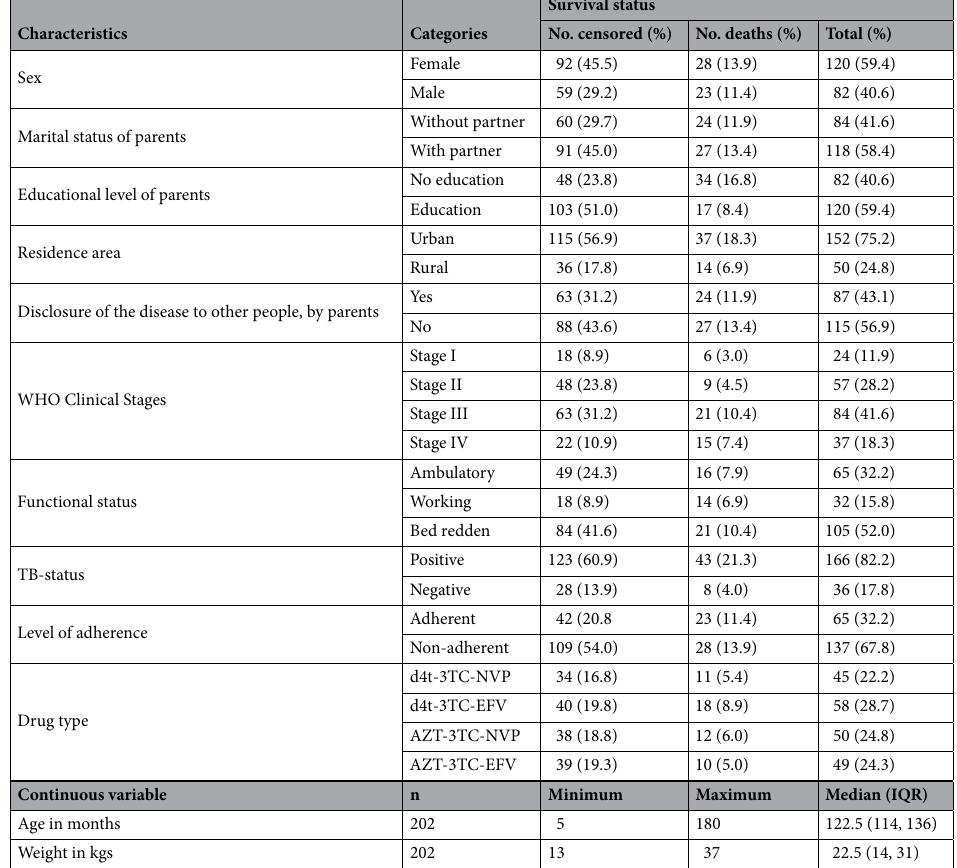
Table 1. Baseline characteristics of participants (n =